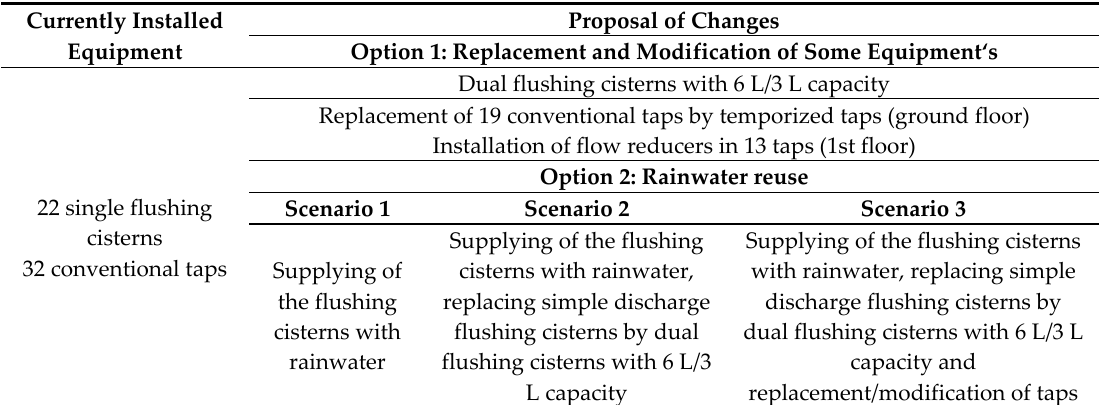
Table 1. Proposed solutions for the reducing of drinking water